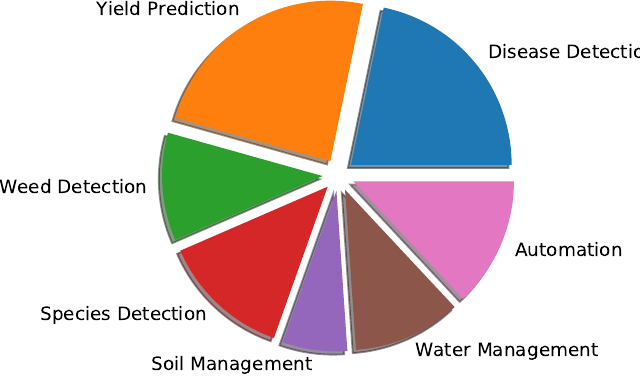
Figure 13. Pie chart representing the papers by application